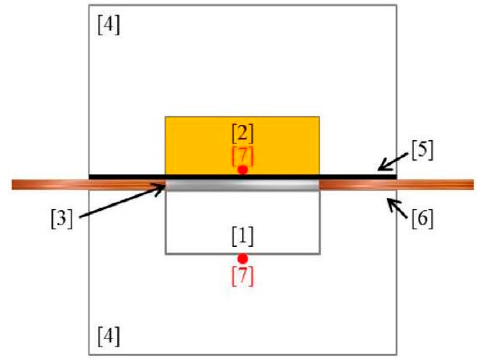
Figure 1. Homemade hot-strip technique. The sample [1] is facing a reference sample made of PU [2] in a temperature-controlled aluminum device [4]. An insulator [5] is protecting the reference sample from the heat flow delivered by the hot-strip technique [3] via electrodes [6]. Two thermocouples [7] allow measuring the temperature of both sides of the sample.